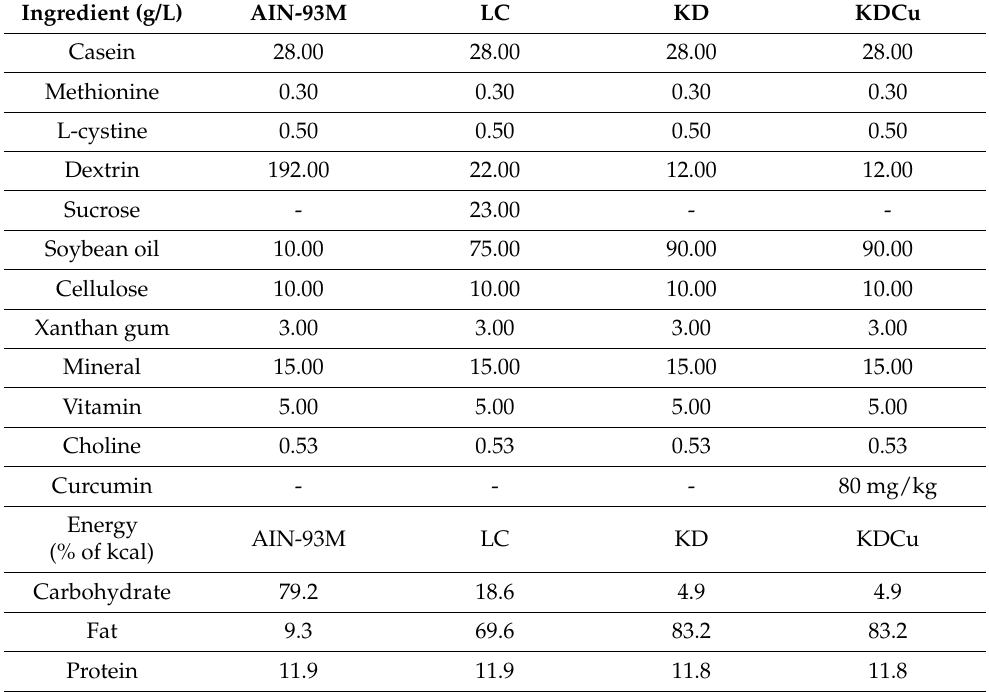
Table 1. Feed ingredients and energy composition of each